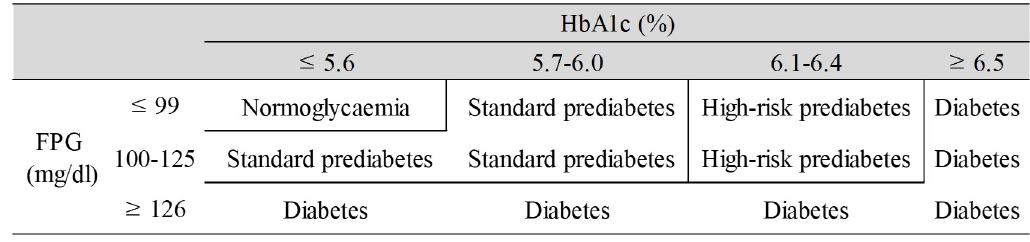
low-density lipoprotein cholesterol (LDL-c), systolic blood pressure (SBP), HbA1c (based on National Glycohemoglobin Standardization Program units), comorbidities (hypertension, hyperlipidemia, diabetes mellitus based on self-administered questionnaire), eating habits, smoking habits, and physical activities at FY2015 were extracted from the database. The FLI